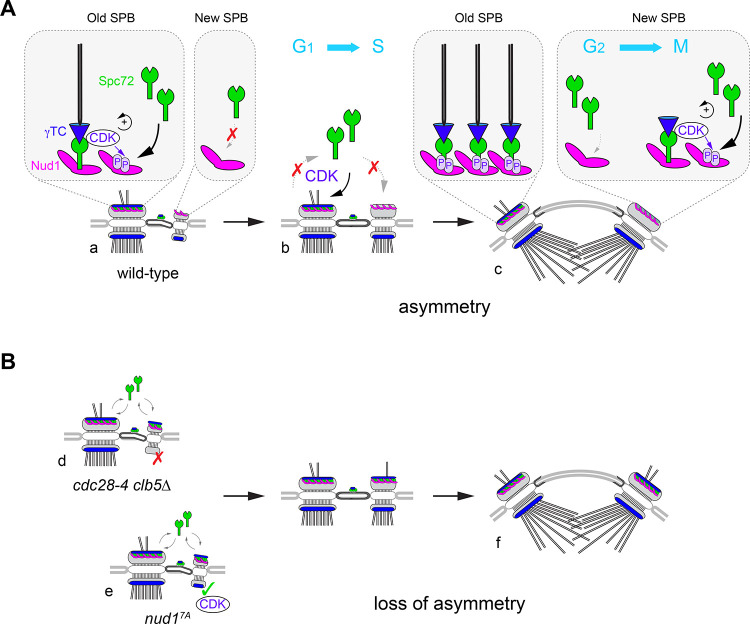
A model for CDK control of intrinsic SPB asymmetry.Our data suggest that CDK phosphosites in Nud1 increase affinity toward Spc72. (A) Because the old SPB inherits Spc72 and Nud1 from the preceding cell cycle (a), CDK recruitment to the old SPB via Spc72 promotes phosphorylation of Nud1 that may reinforce Spc72 retention in wild type cells. De novo Nud1 added to the new SPB (from the satellite state) is presumably not phosphorylated and would have low affinity for Spc72. As a result (b), S-phase CDK enforces structural asymmetry during the side-by-side stage. By onset of spindle assembly (c), low-affinity binding of Spc72 at the new SPB outer plaque may redirect CDK to phosphorylate Nud1 and trigger the phospho-dependent increase in affinity toward Spc72 that accelerates completion of the new SPB outer plaque. Thus, CDK recruitment via Spc72 translates phospho-dependent affinity between Spc72 and Nud1 into intrinsic structural asymmetry. This built-in delay in new outer plaque maturation manifests in temporal asymmetry in γTC recruitment and aMT organization. (B) In the absence of Nud1 phospho-dependent control, Spc72 is no longer restricted to the old SPB during the side-by-side stage with concomitant disruption of intrinsic asymmetry. The more severe phenotype observed upon loss of S-phase CDK implicates further substrates (see text). In cdc28-4 clb5∆ cells (d), Spc72 symmetry is compounded by mis-regulation of the inner plaque allowing for the incorporation of γTC to the new SPB in the reverse order - first at the outer plaque and then at of the inner plaque. By contrast (e), loss of Nud1 phosphosites in nud17A cells, decreases Spc72 asymmetry without otherwise perturbing inner plaque function. Order of γTC addition is retained but acquisition by the outer plaque is advanced as it precedes SPB separation. In both mutants, short spindles display significant loss of outer plaque structural asymmetry (f).